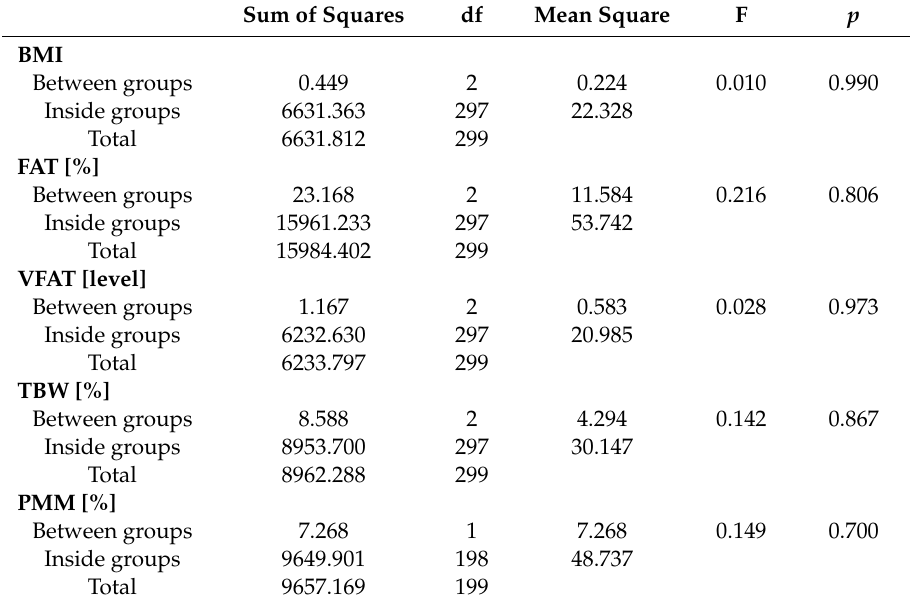
Table 3. Stages of examinations (examinations I, II, III) and components of body mass according to the diets